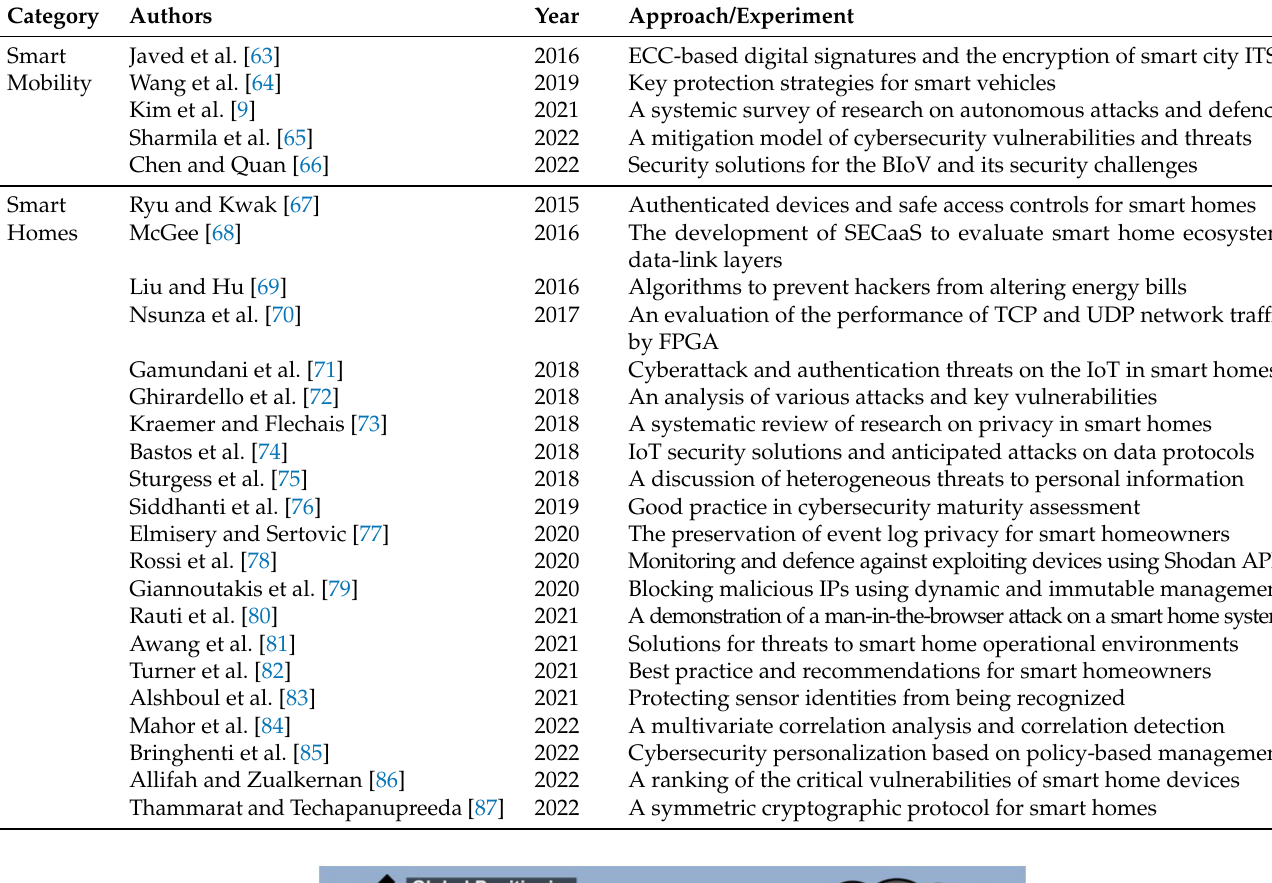
Table 2. Cybersecurity for the service and application layer of smart cities.